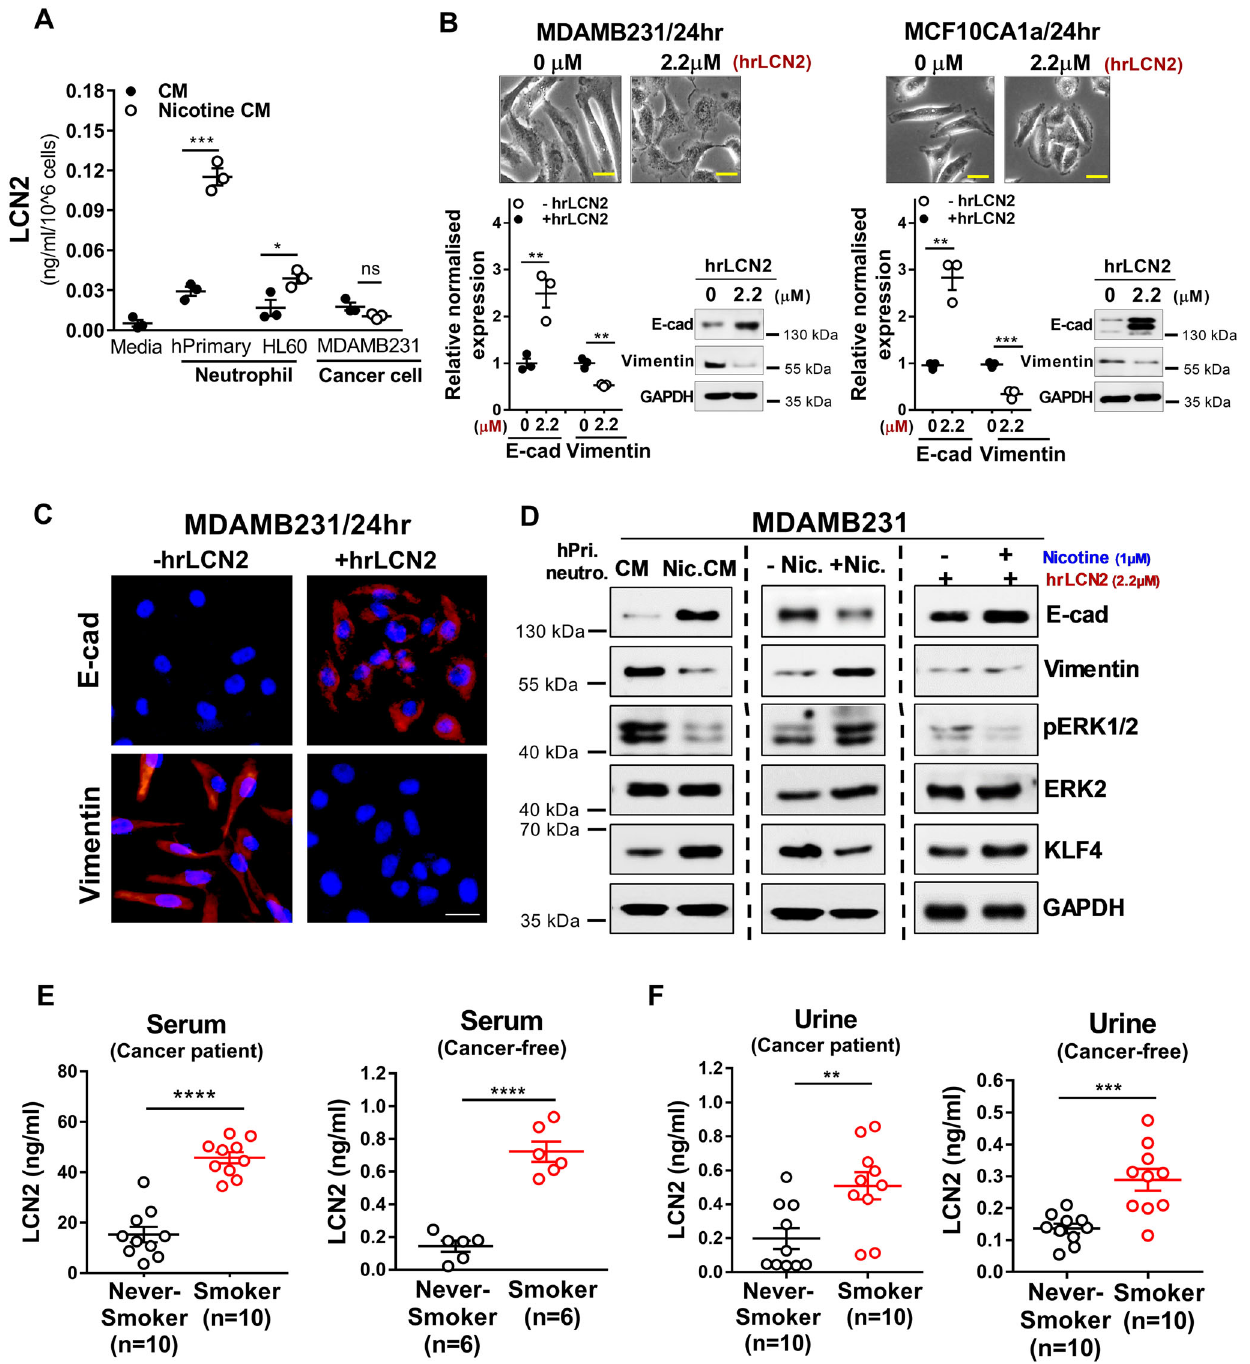
Fig. 5 Nicotine-induced N2 neutrophil increases secretion of LCN2 and regulates epithelial plasticity of cancer cells. A LCN2 protein level in CM derived from nicotine-treated (1 µ M) or untreated neutrophils (human primary and HL-60 cells) and breast cancer cells (MDAMB231) was quanti fi ed by ELISA ( n = 3 individual experiment/group, one-way ANOVA *** p = 0.0003, ** p = 0.03, p = 0.08). B MDAMB231 and MCF10CA1 cells were treated with 2.2 µ m human recombinant LCN2 and the expression of E-cadherin and Vimentin was examined by qRT-PCR and western blot. β -Actin and GAPDH were used as controls [ n = 3 individual experiment/group, unpaired two-tailed t -test, ** p = 0.009, ** p = 0.001 (MDAMB231), ** p = 0.002, *** p = 0.0006 (MCF10CA1a)]. C MDAMB231 cells were treated with or without recombinant LCN2 (2.2 µ M) for 24 h, followed by assessing E-cadherin and Vimentin expression by immunocytochemistry ( n = 3 individual experiment/group; scale bar: 50 µ M). D MDAMB231 cells were treated with indicated CM or nicotine alone or with human recombinant LCN2 (2.2 µ M) to rescue from suppressive effect of nicotine after 24 h. Cells were then examined for the expression of E-cadherin, Vimentin, pERK1/2, ERK2, and KLF4 by western blot. GAPDH was used as a control ( n = 3 individual experiment/group). E , F LCN2 was quanti fi ed in serum and urine samples of stage-II, hormone receptor-negative breast cancer patients ( n = 20 for serum and n = 20 for urine) and cancer-free females subjects ( n = 12 for serum and n = 20 for urine) with or without smoking history by ELISA [unpaired two-tailed t -test, **** p < 0.0001 (serum), ** p = 0.006, *** p = 0.0007 (urine)]. All data are presented as mean ± S.E.M.